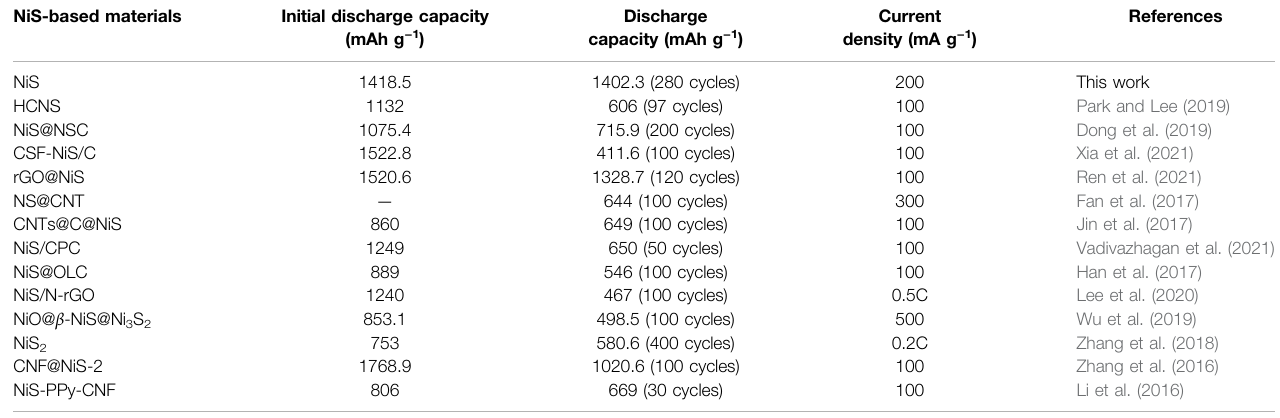
TABLE 1 | Comparison of electrochemical properties between NiS 2 nanospheres and other reported NiS-based materials. NiS-based materials